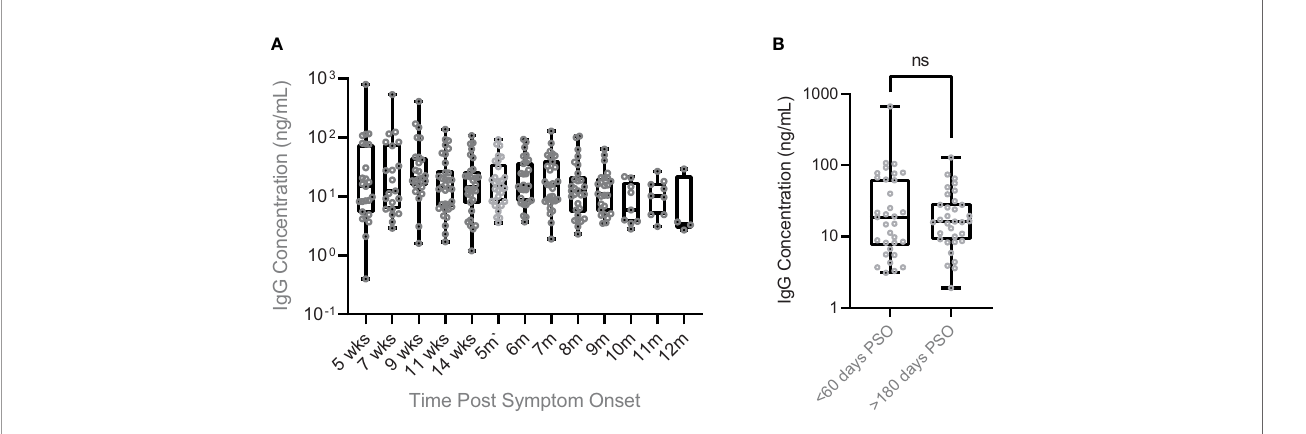
FIGURE 2 | Persistence of SARS CoV-2 IgG antibody levels in oral mucosal fl uids of COVID infected individuals. (A) SARS-CoV-2 IgG antibody concentrations were maintained for up to a year post symptom onset. Individuals who received vaccination during the time of this clinical study had their samples following vaccination omitted from this plot. The average antibody concentration was 62.64 +/- 159.3 ng/mL after 5 weeks PSO and 9.750 +/- 13.04 ng/mL after 12 months PSO. (B) A comparison of SARS-CoV-2 antibody concentration in the early days post symptom onset (<60 days) to the later days (>180 days) fi nds nonsigni fi cant change in concentration over time. The average concentration of early SARS-CoV-2 IgG antibodies collected fewer than 60 days post symptom onset was 51.32 +/- 116.3 ng/ mL, while after more than 180 days post symptom onset the average concentration dropped to 25.17 +/- 25.99 ng/mL. A paired two-sample t-test comparing these means found the decrease to be non-signi fi cant (p = 0.1915). ns, not signi fi cant.